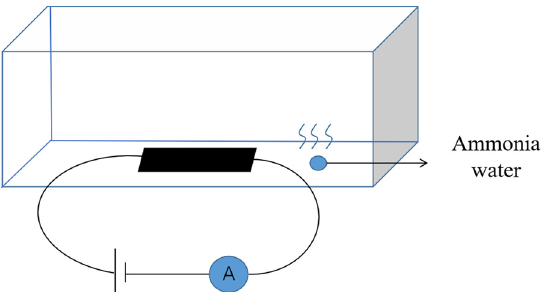
Figure 4: Sensing properties of Ag - CNFs for NH 3 at di ff erent NH 3 contents. After adding NH 3 water, it was allowed to stand for 10 min, and the power - on test time was 1